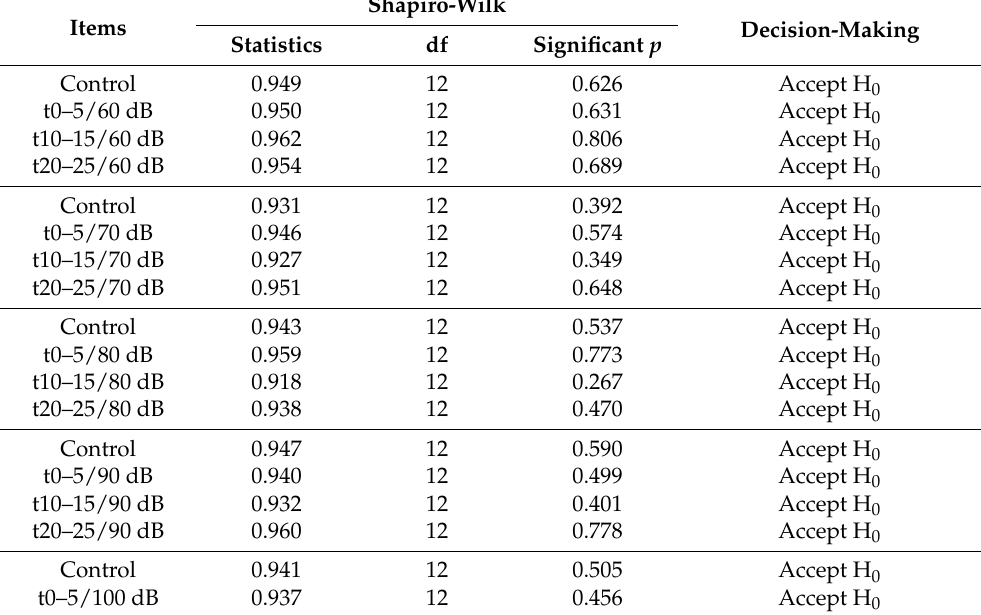
Table 5. Normality test results of heart rate.